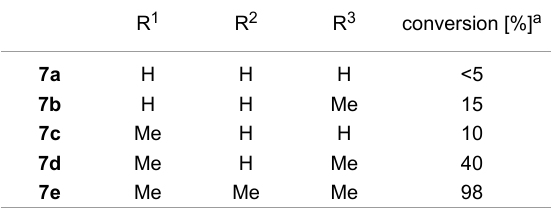
Table 2: Irradiations of 7a – e with a tenfold excess of isoxazoles. R 1 R 2 R 3